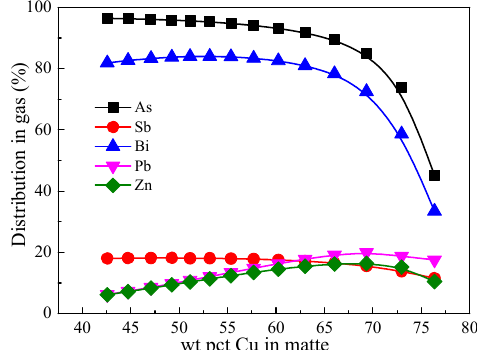
Figure 8. Minor elements distribution in gas calculated by SKSSIM.